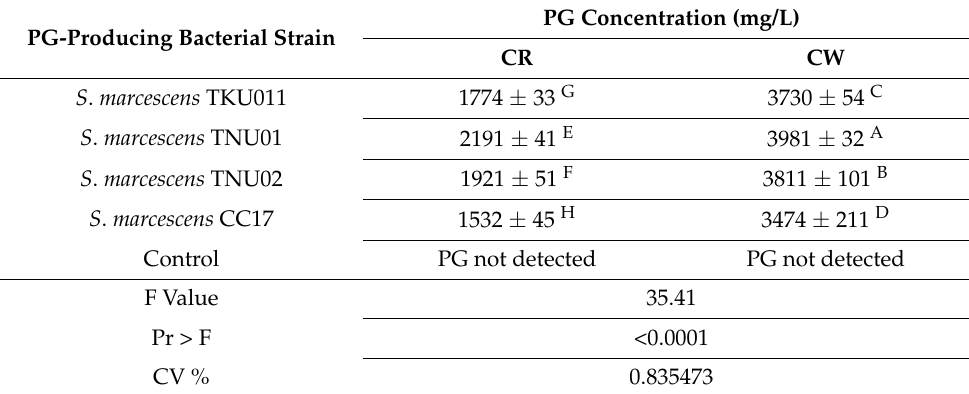
Table 1. Experiments for screening the most suitable PG-producing strain.